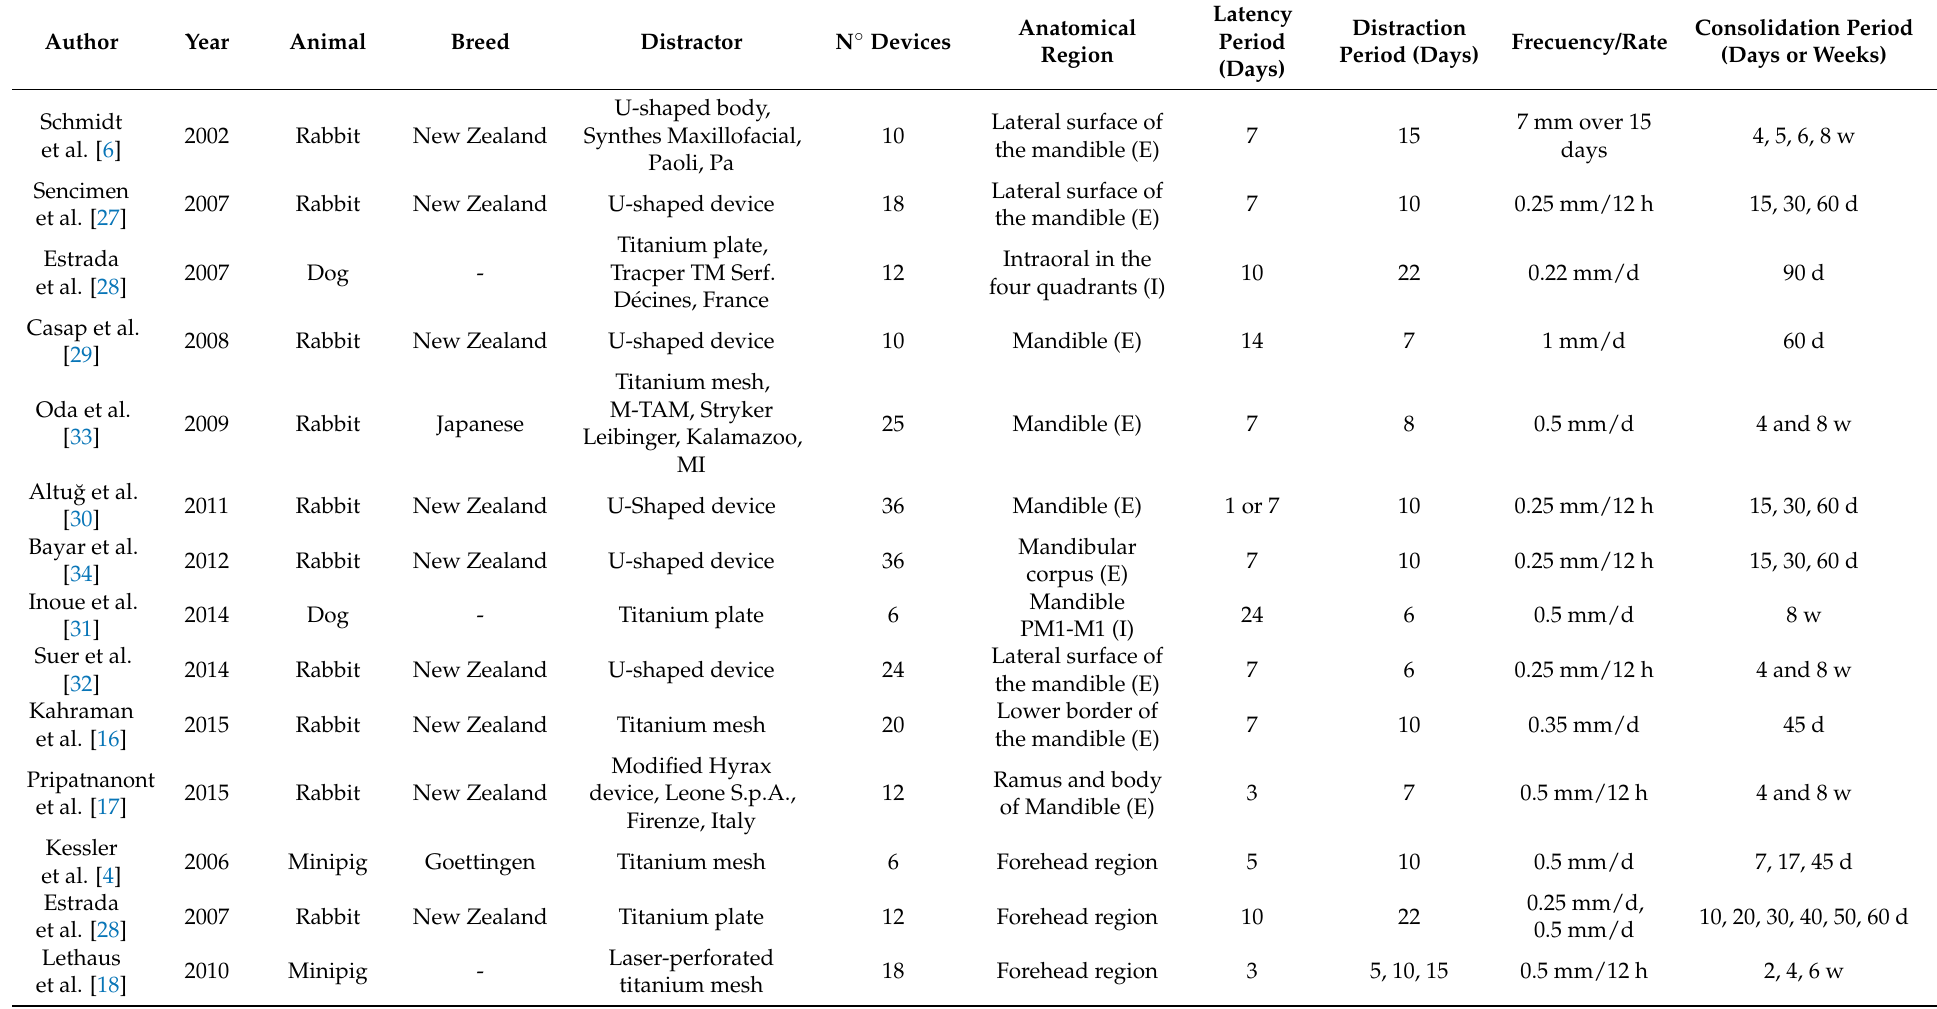
Table 2. Characteristics of the protocols and devices used in each